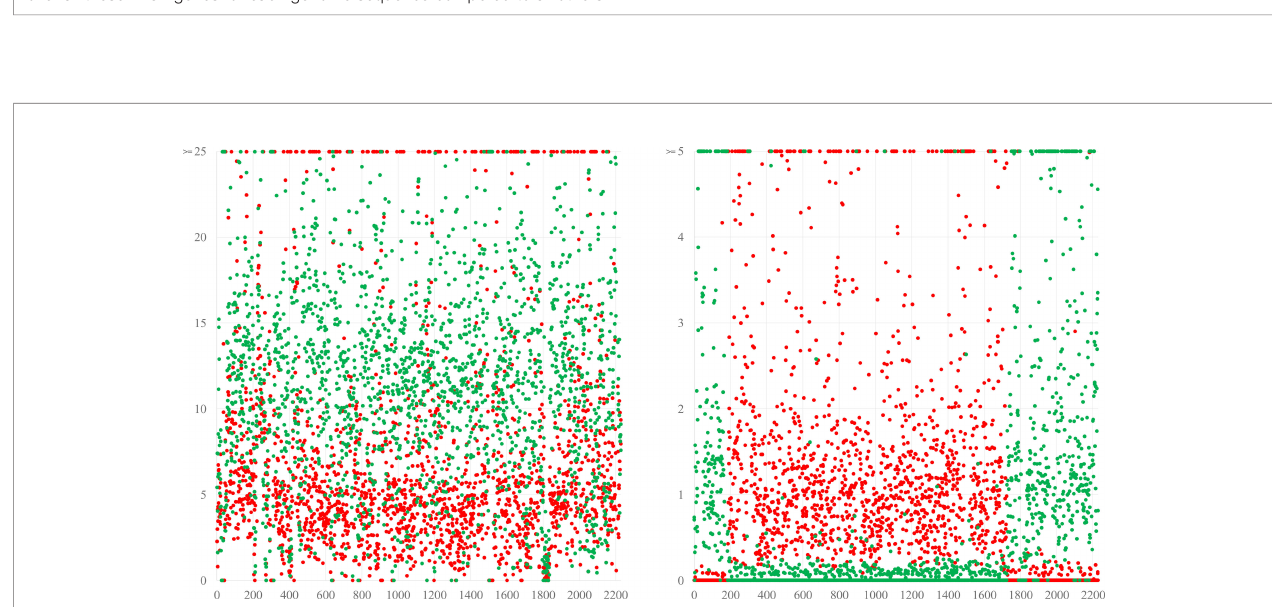
FIGURE 4 | The left diagram shows a simpli fi ed version of the blot from Figure 2 , comparing BDS-53E to the reference sequences of S. schweitzeri NCTC13712 (red) and the S. aureus CC1 strain MW2 (green). Differences are evenly distributed all across the genome, suggesting a continuous evolution and an accumulation of more mutations compared to S. aureus than to S. schweitzeri corresponding supposedly to a longer time of separate evolution. The right diagram shows the same analysis for a chimeric strain in which a fragment of “ red ” origin spanning from approximately position 1750 over oriC (pos. 0) to pos. 200 is integrated into a backbone genome of “ green ” provenance. These are actually S. aureus CC140 and CC8, in a ST6610 strain, see (Burgold-Voigt et al., 2021). For the Y-axes, different scales were used because differences between the different species are larger than those between different CCs of S. aureus